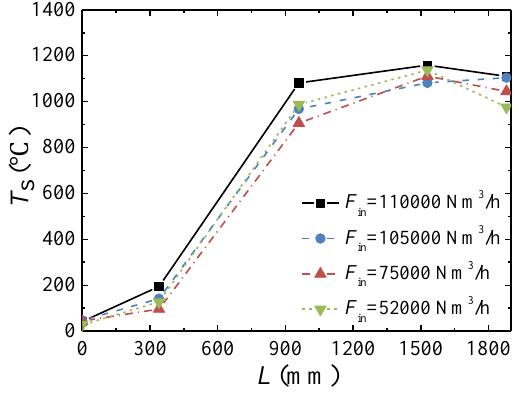
Figure 10. Solid temperature ( T s ) profiles of bed 1 along the length ( L ) of the TFRR for different inlet flow rates ( F in ) at the end of the cycle at Y CH4,in ≈ 1 vol % and t c = 450 s.